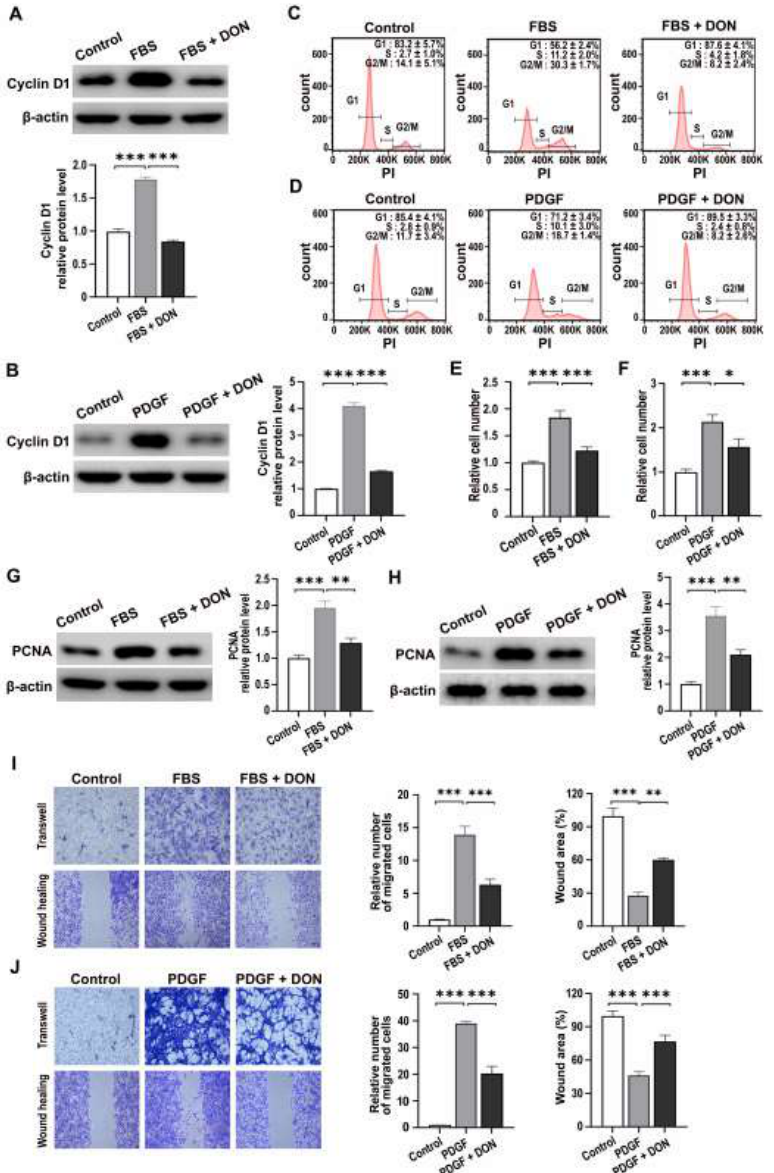
Figure 4. DON delays growth factor-induced cell cycle progression and inhibits proliferation and migration of VSMCs. ( A ) and ( B ) Representative western blots showing the effects of DON on the level of cyclin D1 in VSMCs stimulated with FBS ( A ) and PDGF ( B ). Data in bar graphs are mean ± SEM of three independent measurements. ( C ) and ( D ) Histogram showing the cell cycle distribution of VSMCs stimulated with FBS (C) and PDGF (D). (E and F) Effects of DON on proliferation of VSMCs stimulated with FBS ( E ) and PDGF ( F ). ( G ) and ( H ) Representative western blots showing the effects of DON on the level of PCNA in VSMCs stimulated with FBS ( G ) and PDGF ( H ). Data in bar graphs are mean ± SEM of three independent measurements. ( I ) and ( J ) Transwell migration (upper) and wound healing assays (lower) showing the effects of DON on migration of VSMCs stimulated with FBS ( I ) and PDGF ( J ). Data in bar graphs are mean ± SEM of three independent measurements. * p < 0.05, ** p < 0.01, and *** p < 0.001.